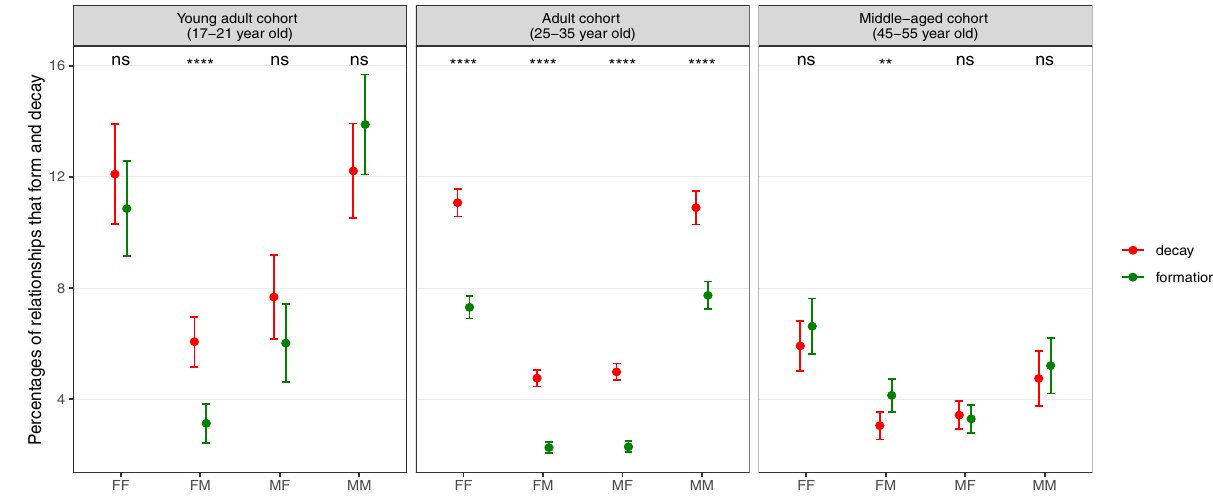
Figure 2. Percentages of ego-alter relationships that have formed or decayed from a close bond among peers in three different age cohorts. Total number of pairs in each group are given in Supplementary Table I. The error bars are shown with 95% confidence level and the p values from two proportions z-test are shown in the top of each panel to illustrate how significantly different the formation and decay percentages are. We have used the following notation scheme to represent the significance levels of p values: not significant (ns) for p > 0.05, and significant to the degree of (*) for p ≤ 0.05, (**) for p ≤ 0.01, (***) for p ≤ 0.001 and (****) for p ≤ 0.0001. Overall the percentage-wise formation and decay of friendship for the young-adult cohort are observed to be higher than those for the adult and middle-aged cohorts. We see a marked difference in the behaviour of female ego’s relationships with their male alters with low values of formation and higher values of decay in the young-adult and adult groups. Moreover, we observe that young adult male egos have the comparatively same values of formation and decay with female alters but change their behaviour in the adult group. The percentage values corresponding to the graph are shown in Supplementary Table III.